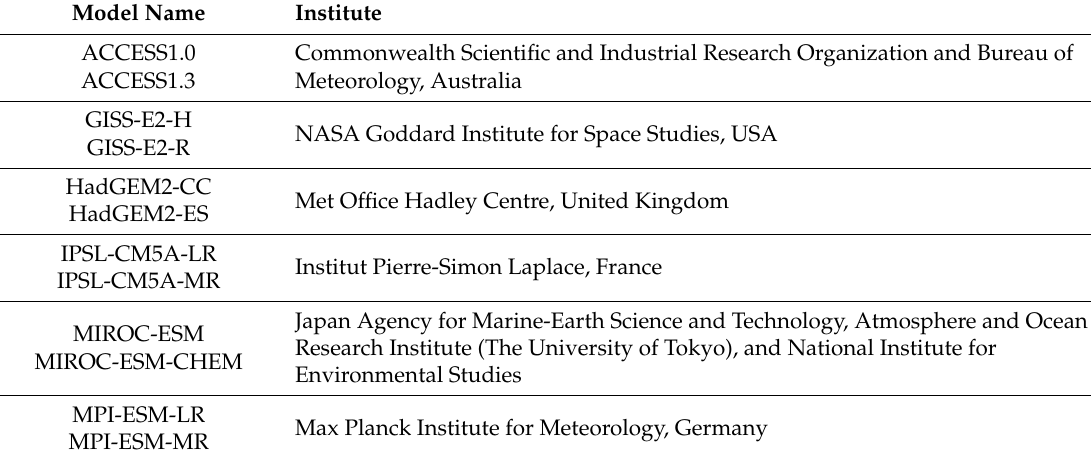
Table 1. Summary of the Coupled Model Intercomparison Phase 5 (CMIP5) earth system models analysed in this